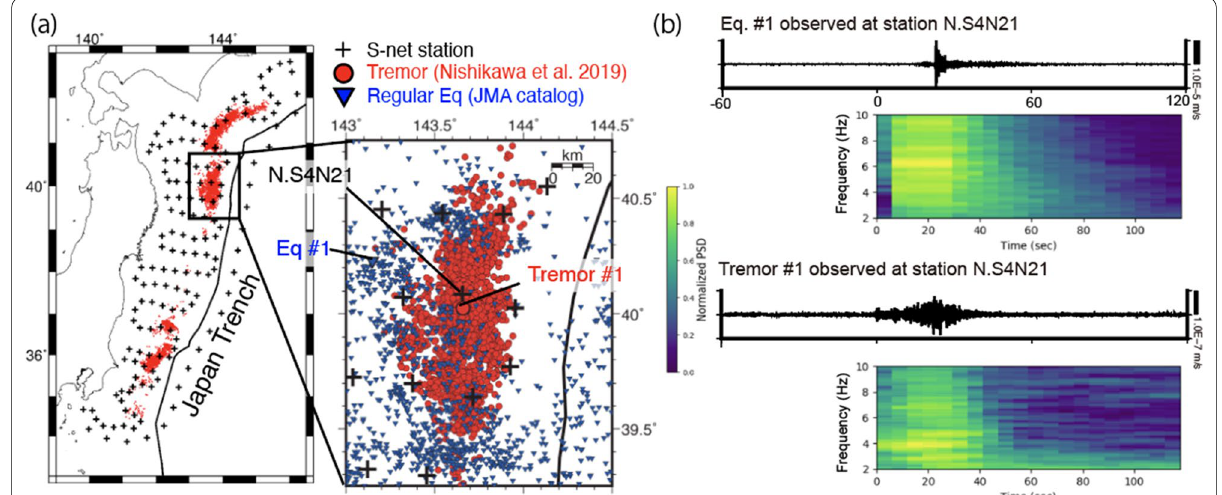
Fig. 1 a Map of the study area. The black crosses indicate S-net stations. The red and blue symbols are the tremor and earthquake epicenters determined by Nishikawa et al. (2019) and JMA, respectively. b Example local earthquake and tremor observations at station N.S4N21. The locations of the example events, Eq #1 and Tremor #1, are shown in a . The upper panel shows a 180-s seismogram record of each example event, with its corresponding spectrogram (normalized from 0 to 1) shown in the lower